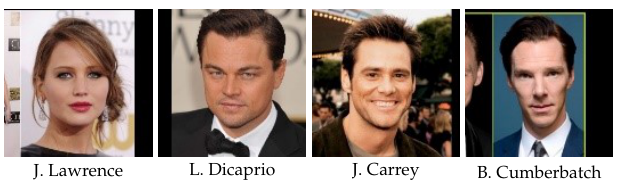
Figure 15. Selected target images for verification from CACD2000 dataset.